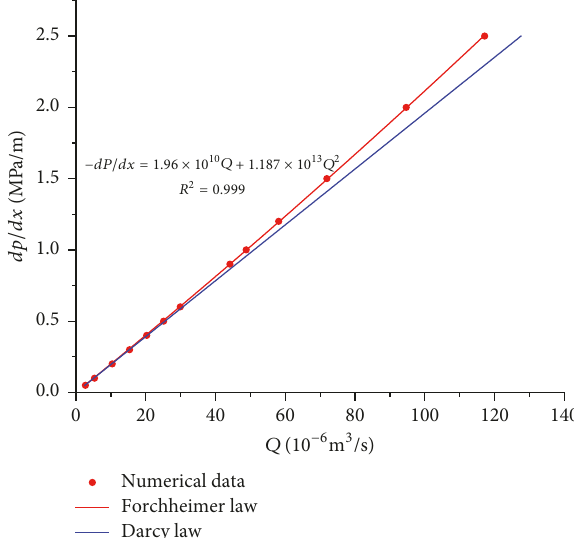
Figure 19: Numerical simulation results of the smooth parallel